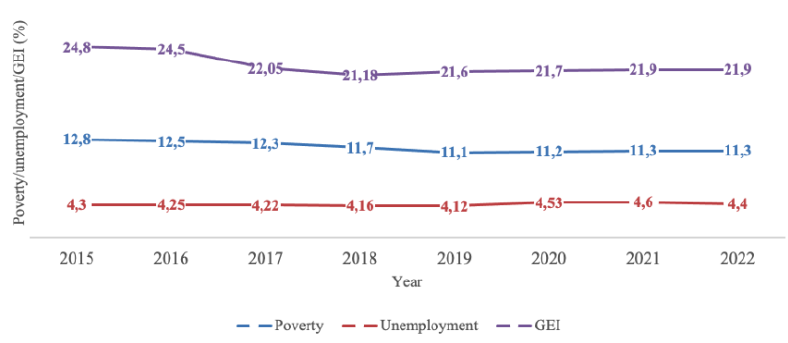
Figure 3: Trend of Poverty, Unemployment and Global Entrepreneurship Index (Gei) in Ghana Source: O’Neil, 2021. Method of entrepreneurship skill